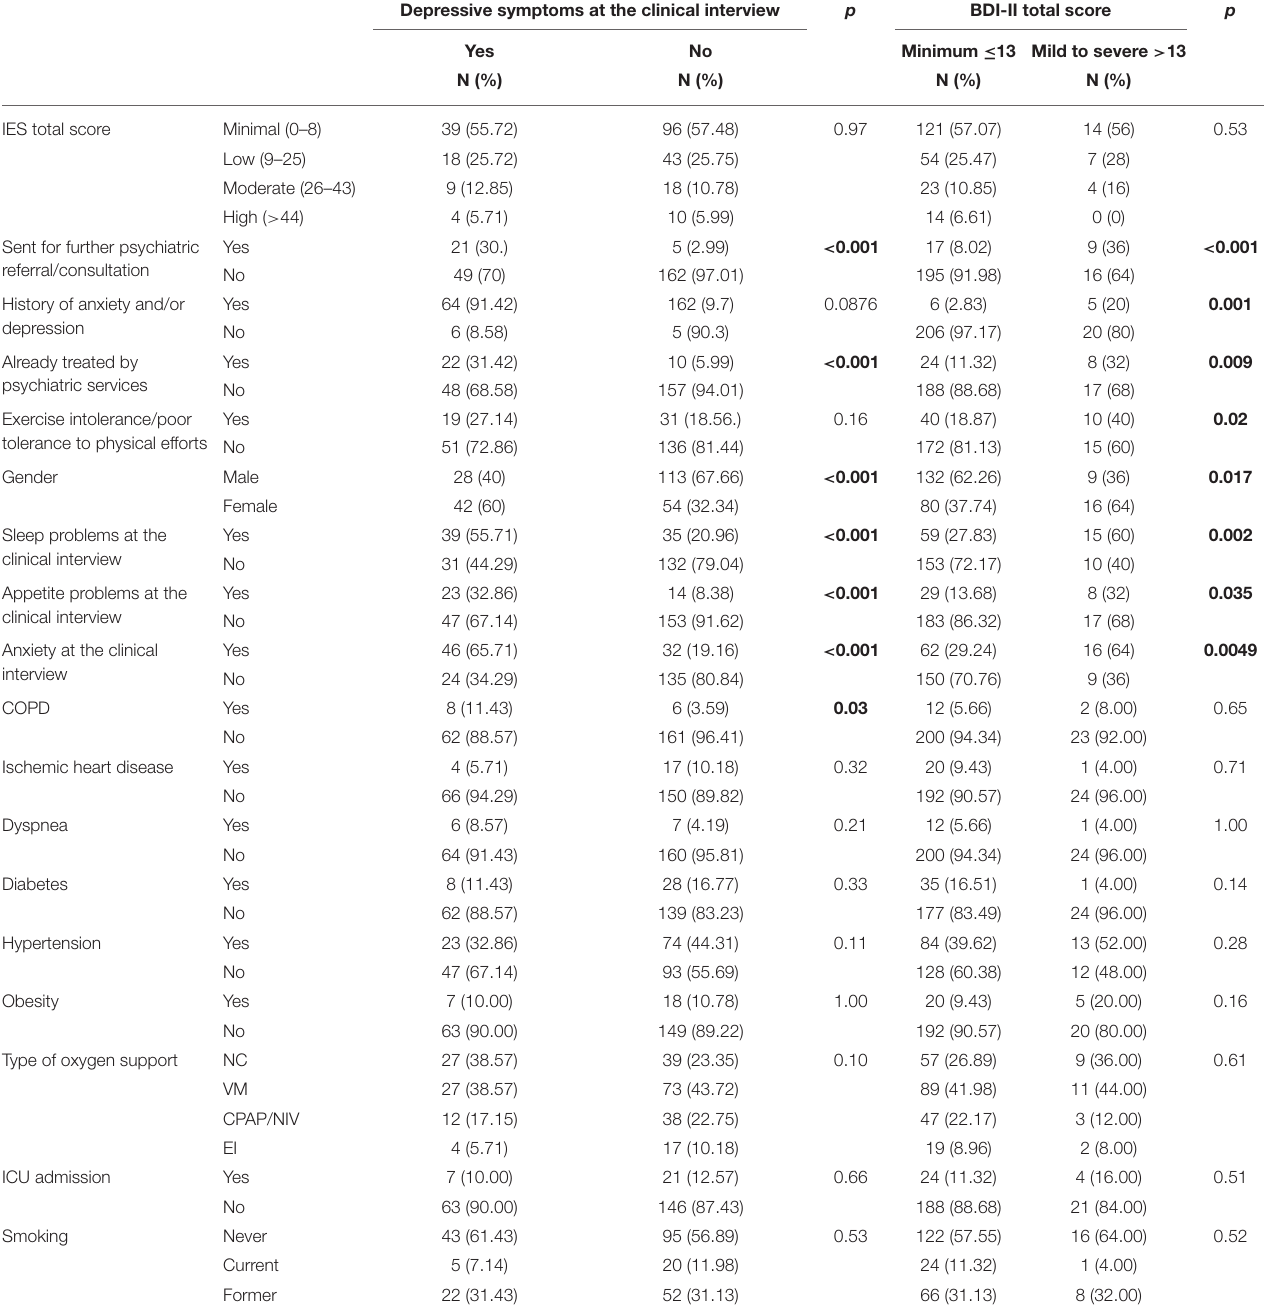
TABLE 4 | Depressive symptoms as assessed at the psychiatric interview and with the BDI-II: chi squared test. Depressive symptoms at the clinical interview p BDI-II total